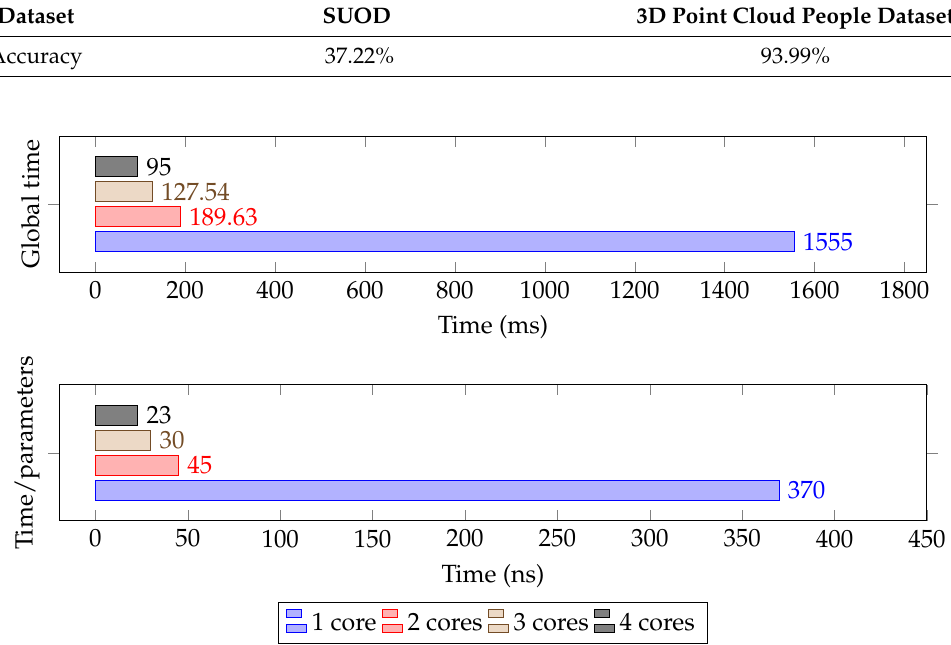
Table 6. Accuracy results per dataset.